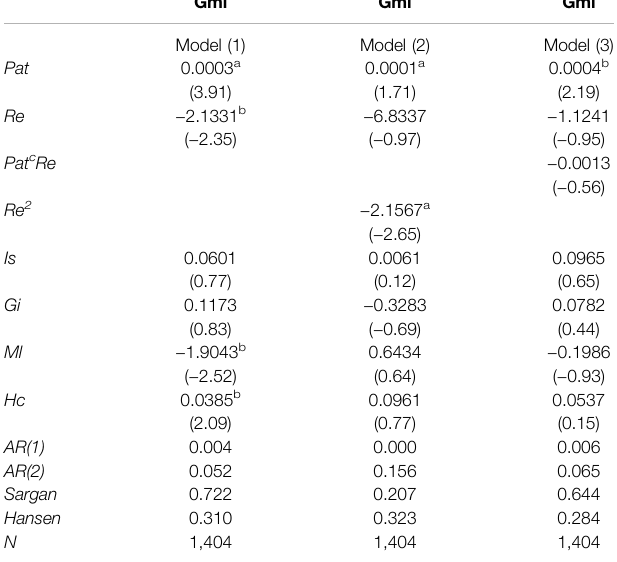
Table 3 re fl ects the full-sample regression results of Models 1, 2,